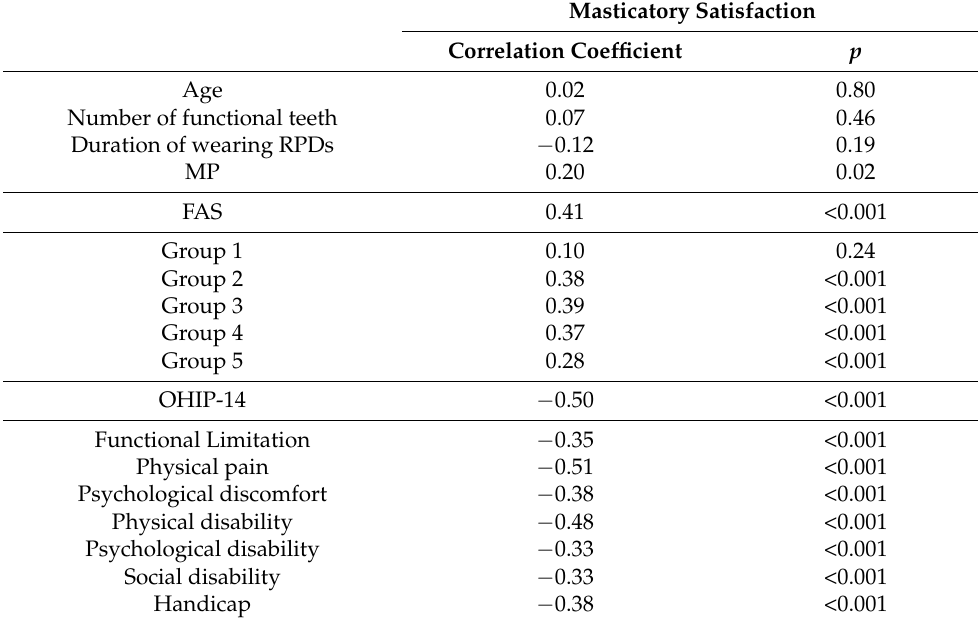
Table 5. The correlation between masticatory satisfaction and survey items.